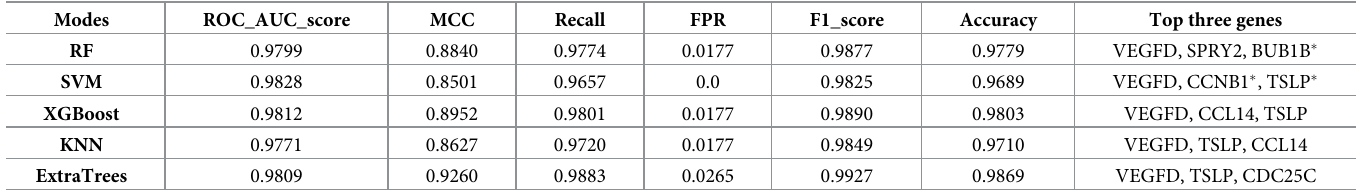
ExtraTrees Genes marked with � are unstable genes in the SDBE algorithm.